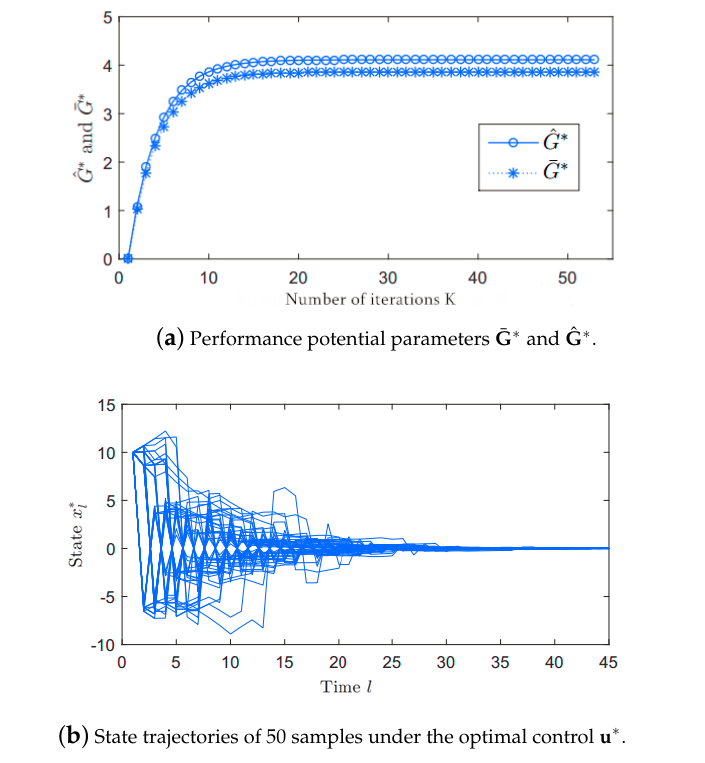
Figure 2. Simulation Results of Example